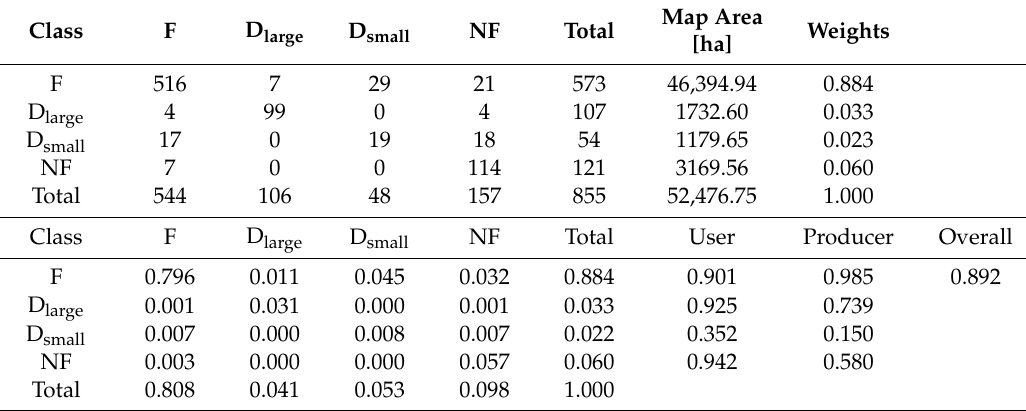
Table A10. “Optical Only” disturbance map validation